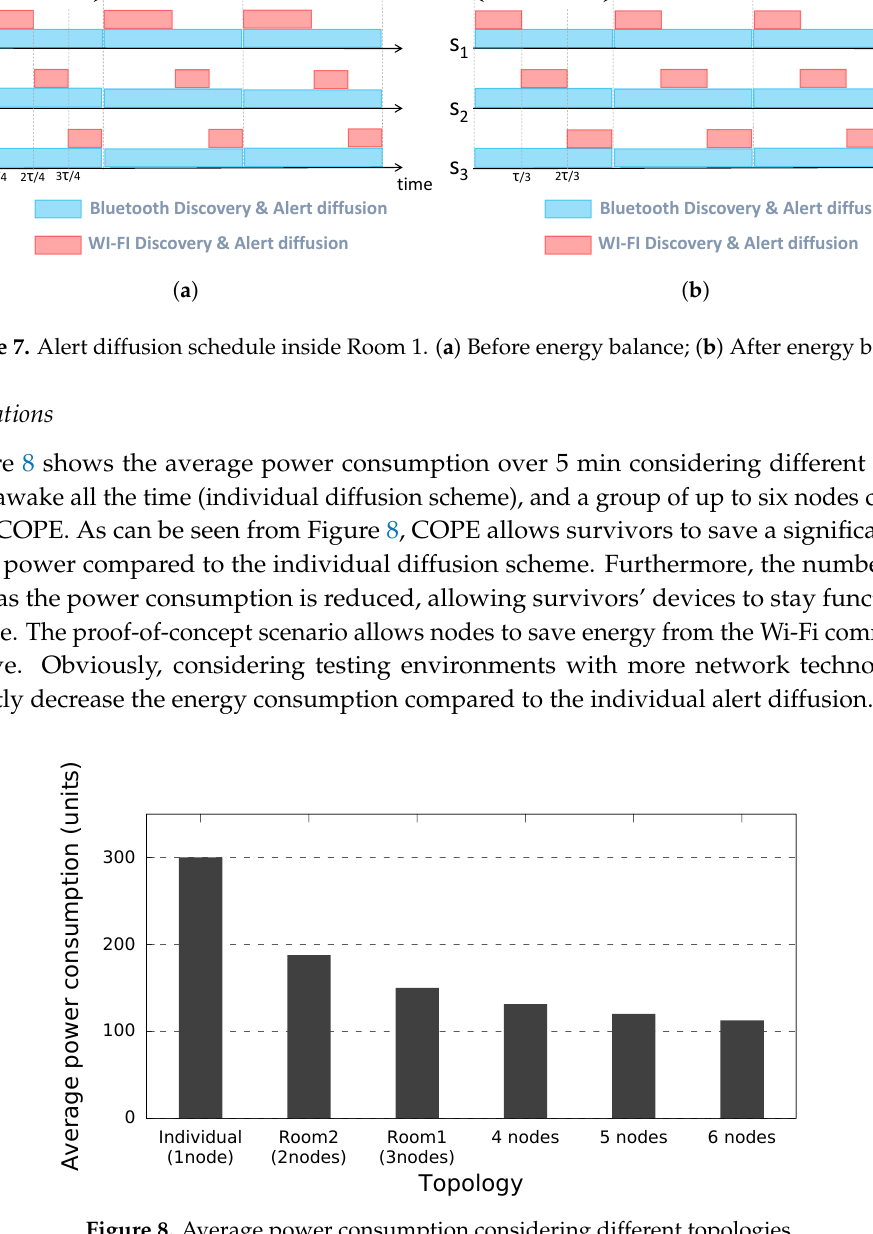
Figure 8. Average power consumption considering different